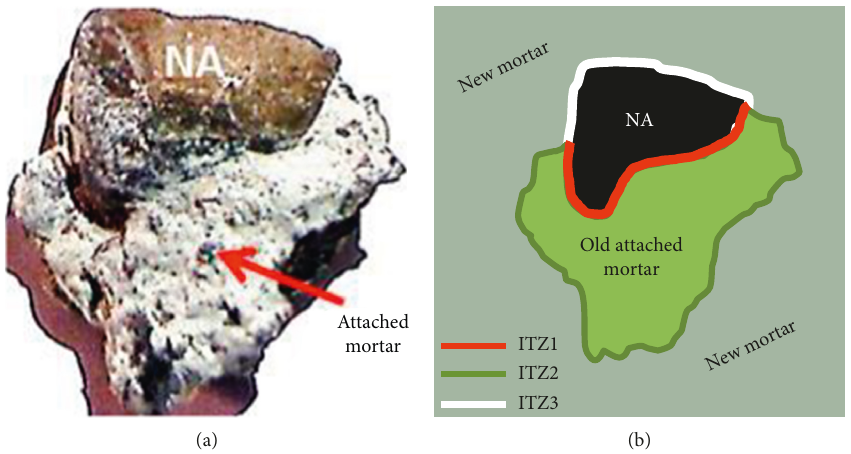
Figure 1: (a) Recycled aggregate (RA) particle. (b) Schematic of the RA particle in RAC showing all